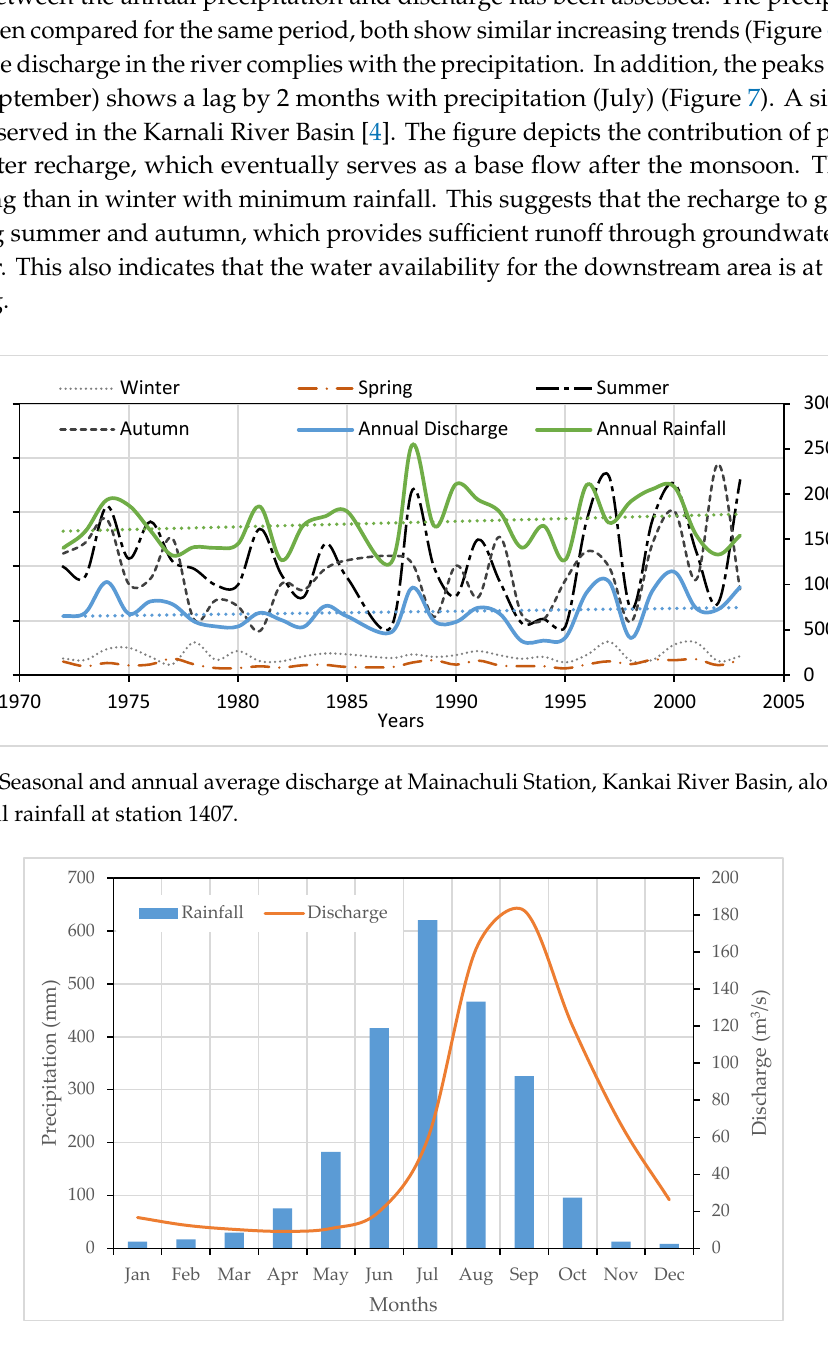
Figure 7. Monthly distribution of precipitaion and average discharge in Kankai River Basin.